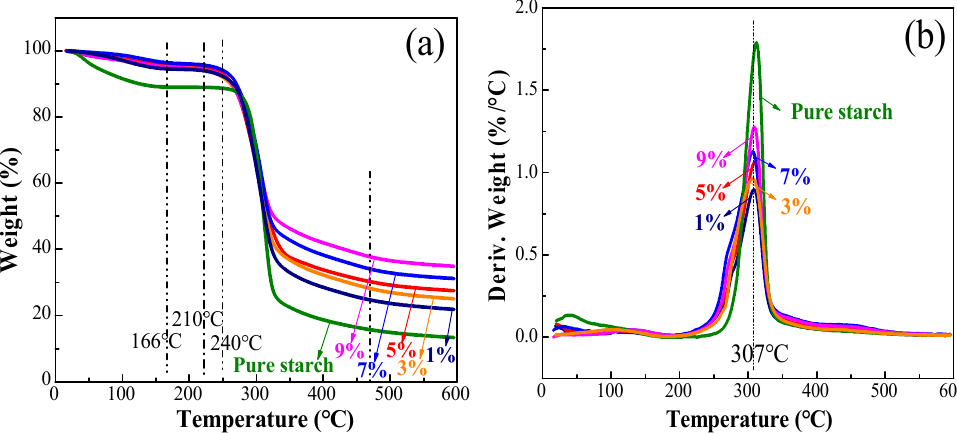
Figure 5. TGA ( a ) and DTG ( b ) curves for control starch film and composite films with various ZnO NP contents.